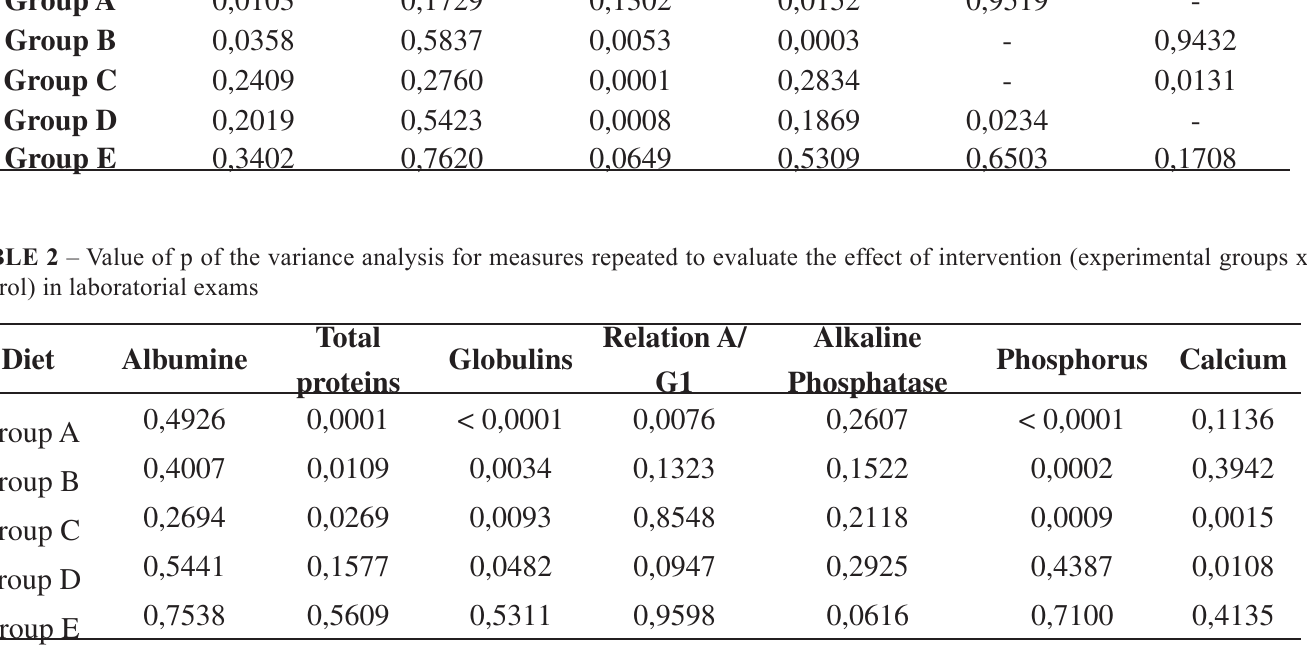
Results of experimental groups in comparison with control group for weight and densitometric variables are shown on Table 1. The two laboratorial variables were carried out at the beginning of medication use (21 st day) and at the end of the response to medications used (89 th day). Table 2 shows the results of albumin dosages, total proteins, globulins, relation albumin/globulin, alkaline phosphatase, phosphorus and calcium of experimental groups in comparison to the control group. Histomorphometric variable was performed at the end of the whole study (89 th day). The areas were compared by using the Student’s T test, because the Test by Bartlett detected homogeneity of variances. Results showed no significant differences in all the comparisons made.